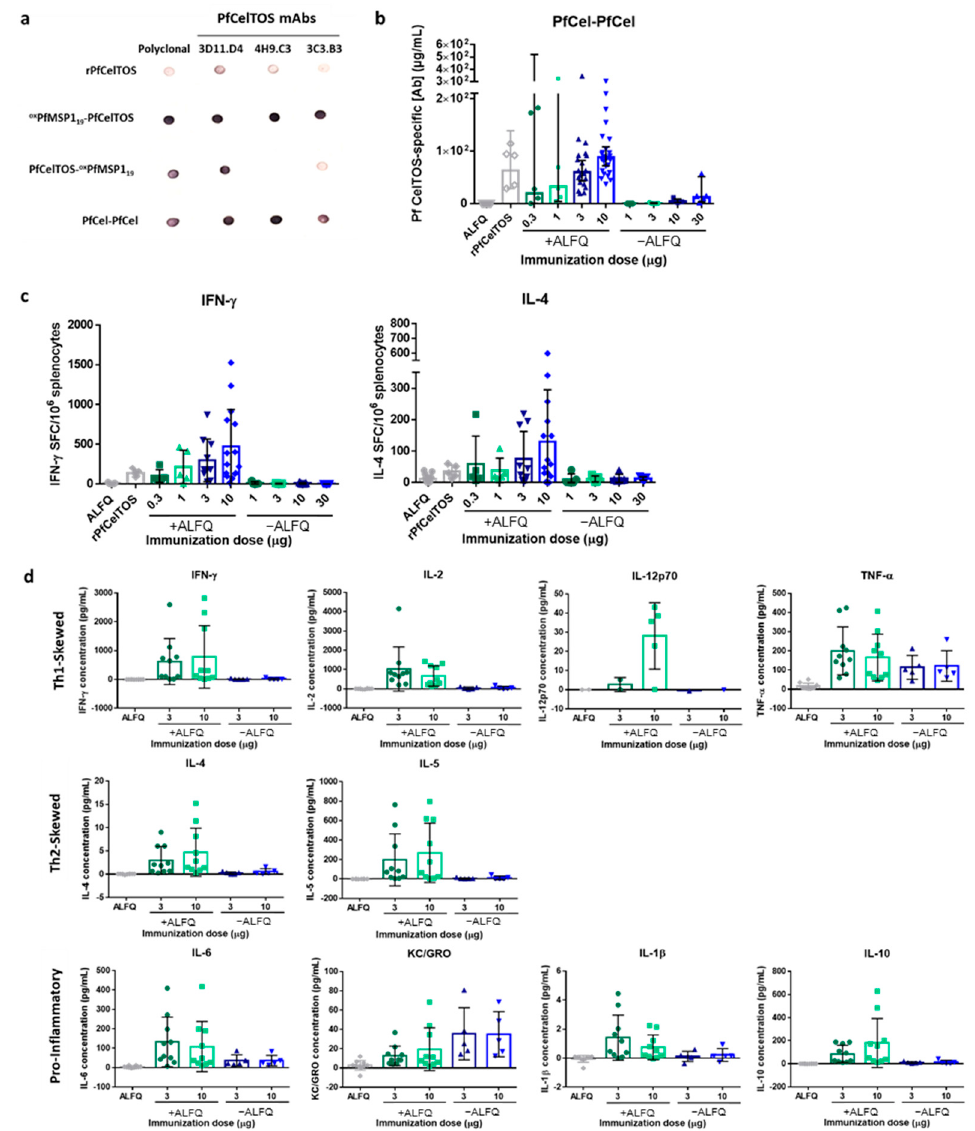
Figure 5. Immunogenicity of N-terminal and C-terminal displayed PfCelTOS on PfCel-PfCel SAPN. ( a ) Reactivity of P. falciparum CelTOS antibodies to PfCel-PfCel SAPN. Nitrocellulose membrane was spotted with 250 ng of folded proteins and incubated with antibodies as described in Materials and Methods. ( b ) BALB/c mice were immunized I.M. 3 times at a 3-week interval with PfCel-PfCel SAPN with (0.3 µ g, n = 5; 1 µ g, n = 5; 3 µ g, n = 20; 10 µ g, n = 25) and without (1 µ g, n = 5; 3 µ g, n = 5; 10 µ g, n = 5; 30 µ g, n = 5) Army Liposome Formulation with QS-21 (ALFQ) adjuvant, recombinant PfCelTOS (10 µ g, n = 5) with ALFQ, or ALFQ alone (n = 20). Antigen-specific antibody concentrations against rPfCelTOS were quantified by ELISA. Final antibody concentrations are shown for individual mice, with the geometric mean and 95% CI. ( c ) IFN- γ - and IL-4-secreting cells were quantified by ELISpot after stimulation of splenocytes with rPfCelTOS. The number of cytokine-specific spot-forming cells (SFC) per 10 6 splenocytes is shown for individual mice (n = 5 for all groups except the 3 µ g and 10 µ g doses with ALFQ and ALFQ alone groups, which have n = 10, n = 15, n = 15, respectively), with the mean and SD. ( d ) Cytokine production was quantified using the Meso Scale Discovery immunoassay. Cytokine-specific concentrations are shown for individual mice (n = 10 for groups with ALFQ, n = 5 for groups without ALFQ, except IL-12p70 for which some mice were below the level of detection), with the mean and SD. Results are representative of three independent